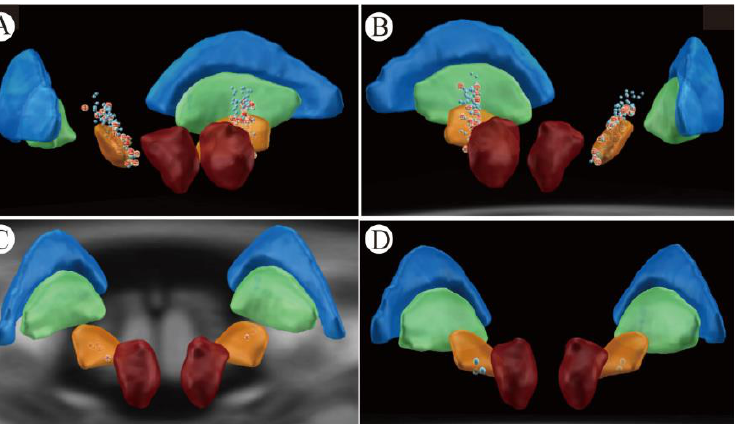
Figure 1. Location of effective stimulation contacts for STN-DBS to reduce RLS. ( A ) (left posterior — anterior view), and ( B ) (right posterior — anterior view) show the locations of all activated contacts (red spheres) and inactive contacts (blue) for 33 patients. ( C ) (posterior–anterior view) shows effective programmed contacts in nine patients with exacerbated RLS symptoms. ( D ) shows activation contact locations in five patients with acute RLS symptoms induced by electrical stimulation. In the figures, the yellow sphere is the subthalamic nucleus, the green sphere is the globus pallidus internal segment, the blue sphere is the globus pallidus external segment (GPe), and the red sphere is the red nucleus.